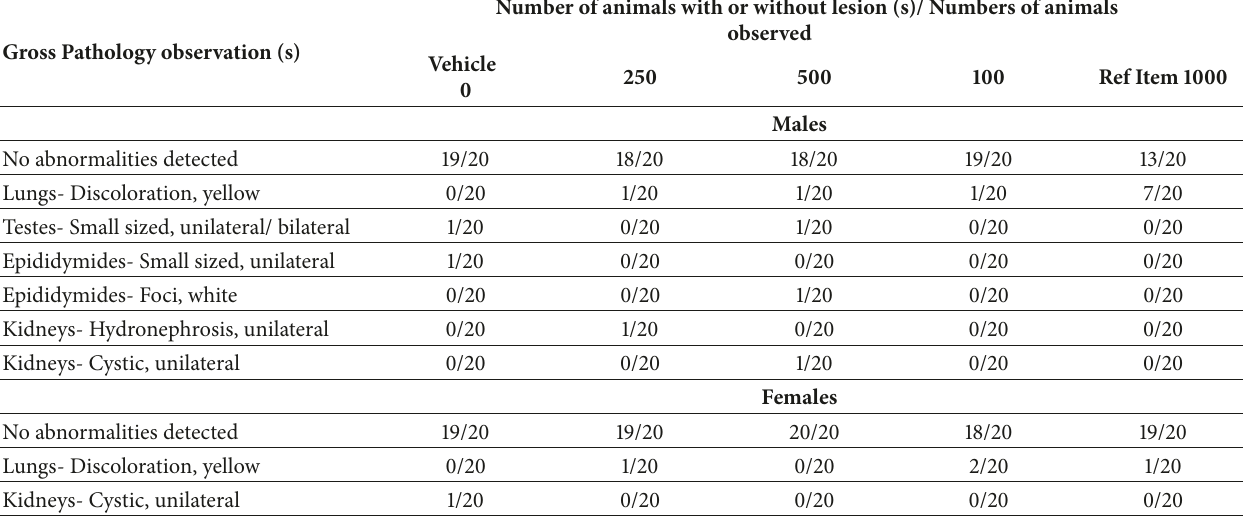
Table 15: Summary of gross pathology findings in the 90-day study on